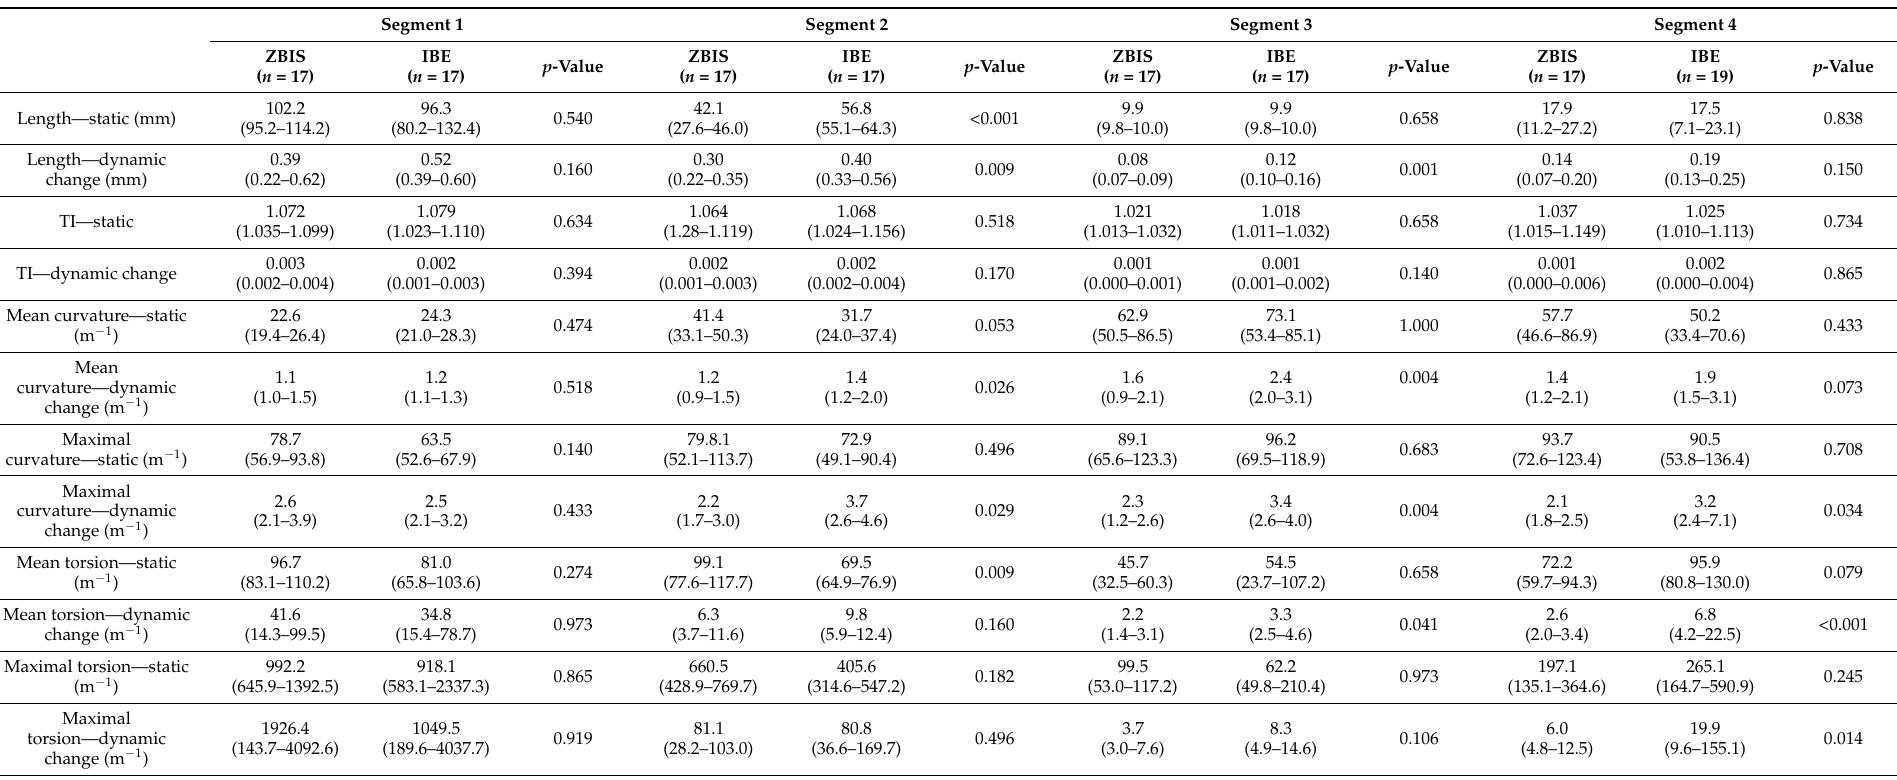
Table 3. Static and dynamic change of centerline parameters (length, tortuosity index [TI], mean curvature, maximum curvature, mean torsion and maximum torsion) for each centerline segment of the iliac branched devices (IBD): the Cook Medical Zenith bifurcated iliac side (ZBIS) and the Gore Excluder platform iliac branched endoprosthesis (IBE) groups: Segment 1, main EVAR flow divider to IBD flow divider; Segment 2, IBD flow divider to 5 mm upstream of the end of the internal iliac artery (IIA) component; Segment 3, 5 mm upstream to 5 mm downstream of the end of the IIA component; Segment 4, 5 mm downstream of the end